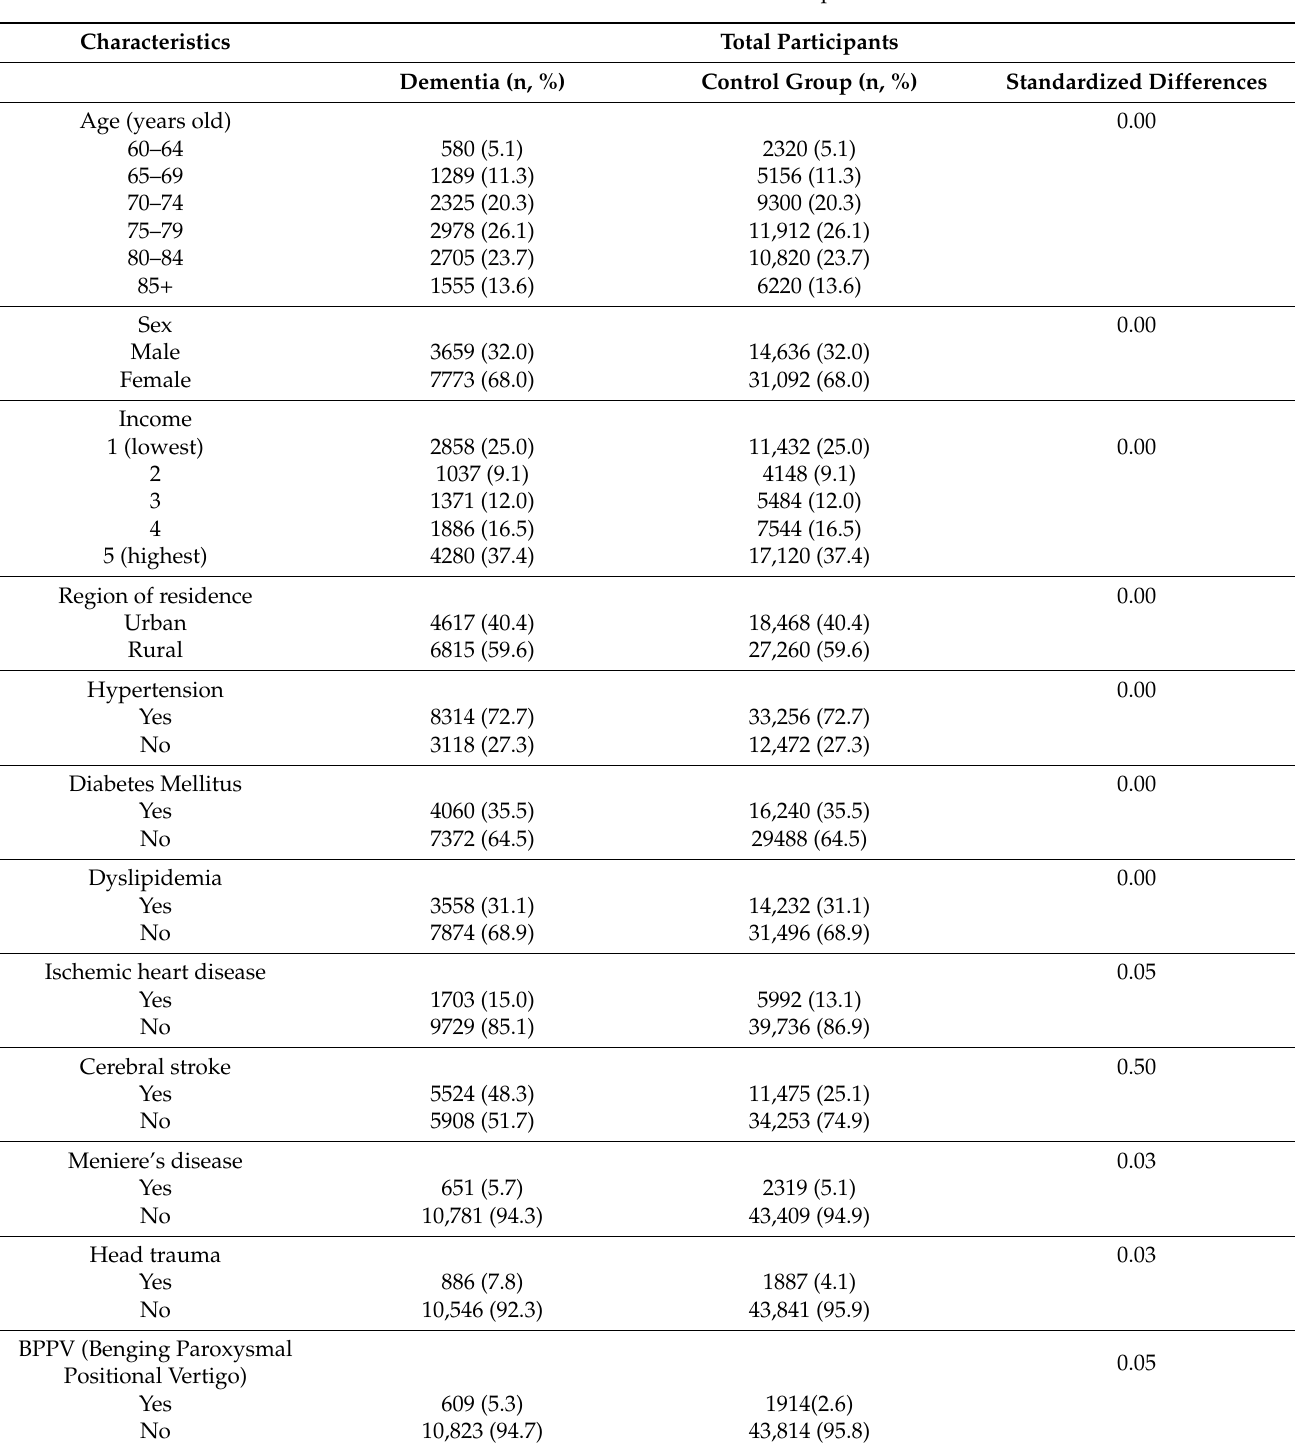
Table 1. General Characteristics of